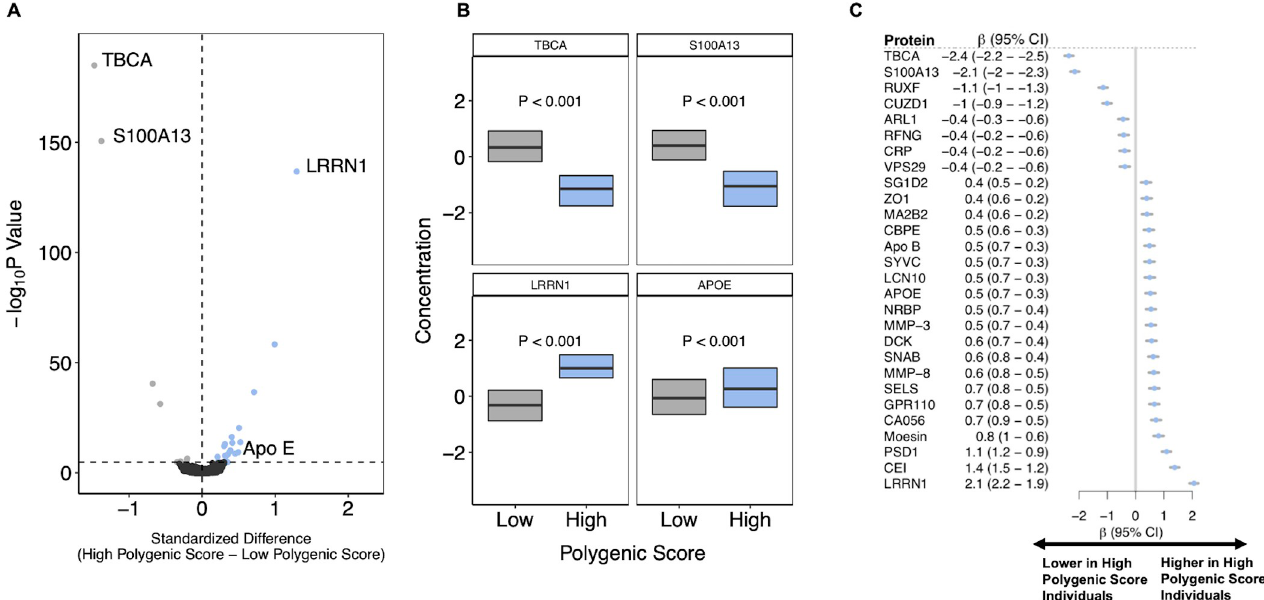
Fig 3. Proteomic signature of inherited risk for Alzheimer’s disease a. The levels of each of 3,231 plasma proteins quantified using an aptamer-based assay were compared between 636 participants from the INTERVAL study with top versus bottom decile of the polygenic score in models adjusted for age, sex, duration between blood draw and processing and the first three principal components of ancestry. The x-axis shows difference–in standardized units with mean 0 and standard deviation 1 –in concentration and the y-axis -log 10 p-value for strength of association. The horizontal dashed line represents the Bonferroni-corrected threshold for statistical significance ( P < 1.55 x 10 − 5 ). b. Boxplots show levels of the three most significantly associated proteins and apolipoprotein E, a known Alzheimer’s disease-related protein. c. The associations between 28 proteins with levels that significantly differed according to high vs low polygenic score. The x-axis refers to the difference in concentration in standardized units. Whiskers represent 1.5 � IQR. TBCA: tubulin-specific chaperon protein A; S100A13: S100 calcium-binding protein A13; RUXF: Small Nuclear Ribonucleoprotein Polypeptide F; CUZD1: CUB and zona pellucida- like domain-containing protein 1; ARL1: ADP-ribosylation factor-like protein 1; CRP: C-reactive protein; VPS29: Vacuolar protein sorting-associated protein 29; SG1D2: Secretoglobin Family 1D Member 2; ZO1: Tight junction protein 1; MA2B2: Mannosidase Alpha Class 2B Member 2; CPBE: Choline binding protein E; ApoB: Apolipoprotein B; SYVC: Valyl-TRNA Synthetase 1; LCN10: Lipocalin 10; APOE: Apolipoprotein E; NRBP: Nuclear Receptor Binding Protein 1; MMP-3: matrix metalloproteinase-3; DCK: Deoxycytidine kinase; SNAB: Beta-soluble NSF attachment protein; MMP-8: matrix metalloproteinase-8; SELS: Selenoprotein S; GPR110: Adhesion G-protein coupled receptor F1; CA056: Protein MENT; PSD1: PH and SEC7 domain-containing protein 1; CEI: Protein CEI; LRRN1: Leucine-rich repeat neuronal protein 1